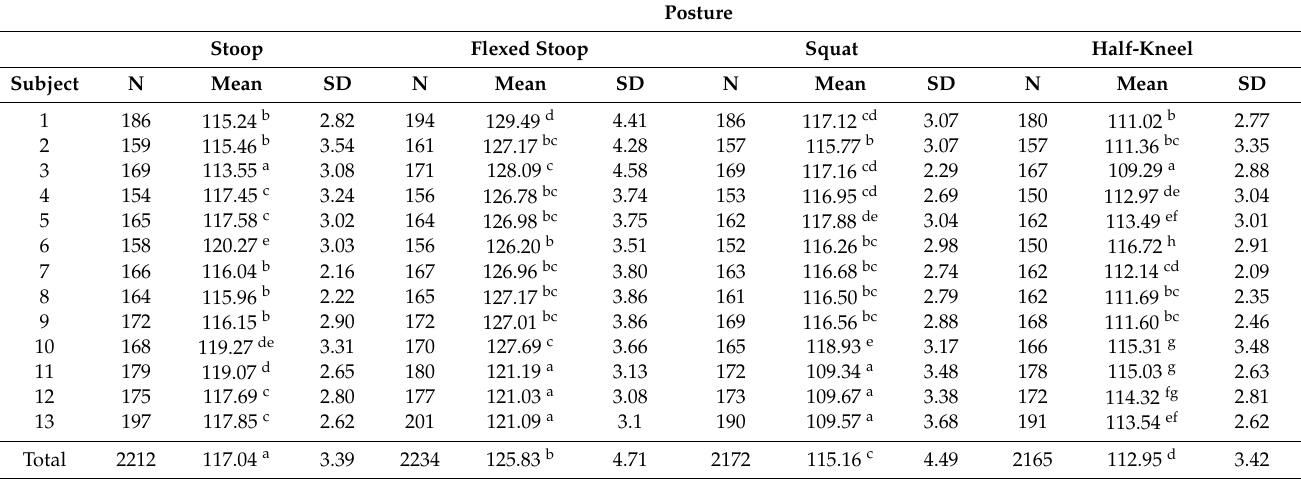
Table 5. Average heart rate during tree felling (HR work ) in bpm per study subject for the examined body postures. Posture